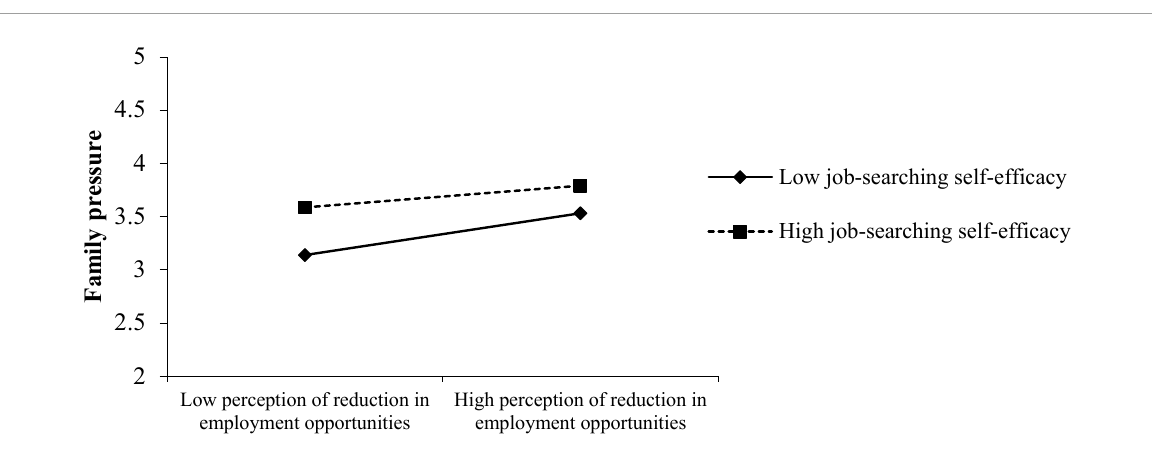
FIGURE6 The role of job-searching self-efficacy on the perception reduction of employment opportunities on the employment pressure of college students’